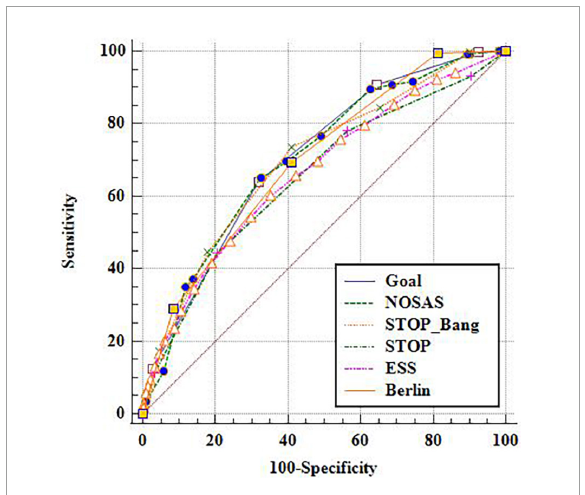
FIGURE3 ROC curve with apnea hypopnea index (AHI) 30 as cut-off point.